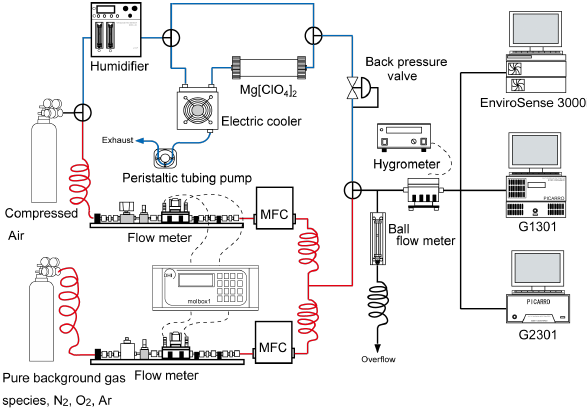
Fig. 1. Schematic diagram of the experimental system. The system Figure 1. Schematic diagram of the experimental system. The system consists of a sample 2 consists of a sample humidification unit and a dynamic gas blending humidification unit and a dynamic gas blending unit. Compressed air is supplied to the WS- 3 unit. Compressed air is supplied to the WS-CRDS instruments after CRDS instruments after adjustment of water vapor concentration via the humidification unit 4 adjustment of water vapor concentration via the humidification unit (blue line), while the mole fraction of the background gas in the sample air is adjusted 5 (blue line), while the mole fraction of the background gas in the through the dynamic gas blending unit (red line). See more detail in the text. 6 sample air is adjusted through the dynamic gas blending unit (red line). See more detail in the